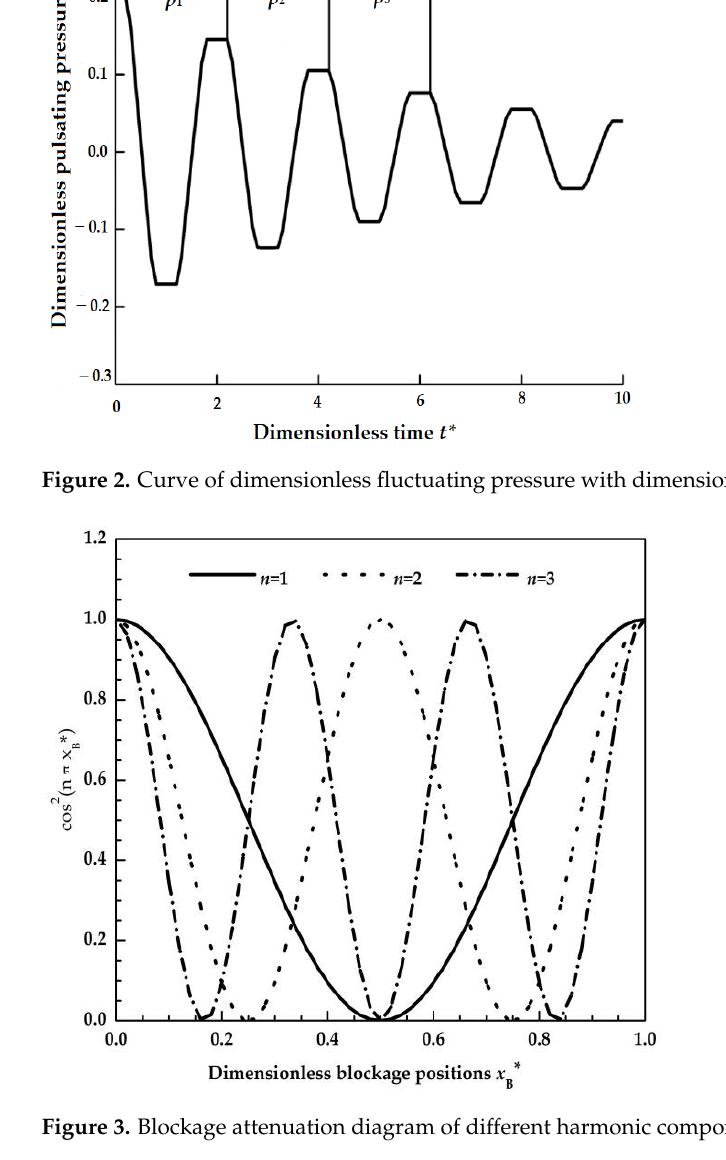
Figure 3. Blockage attenuation diagram of different harmonic components.